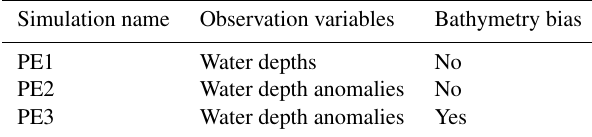
Table 2. List of data assimilation experiments. All experiments are run over approximately 1 year (17 cycles of 21d) starting on 1 Jan- uary 2008. The ensemble size is n e = 25, the observation error stan- dard deviation is σ o = 0 . 1m and the initial control variable error standard deviation is σ b = 0 .